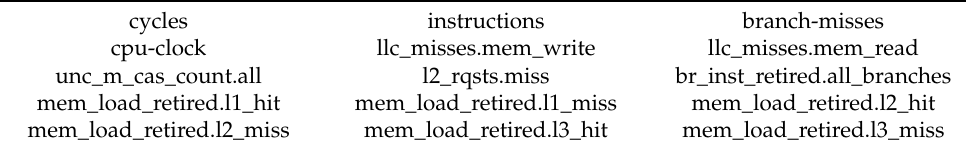
Table 1. All the uncore-related performance events we select as input